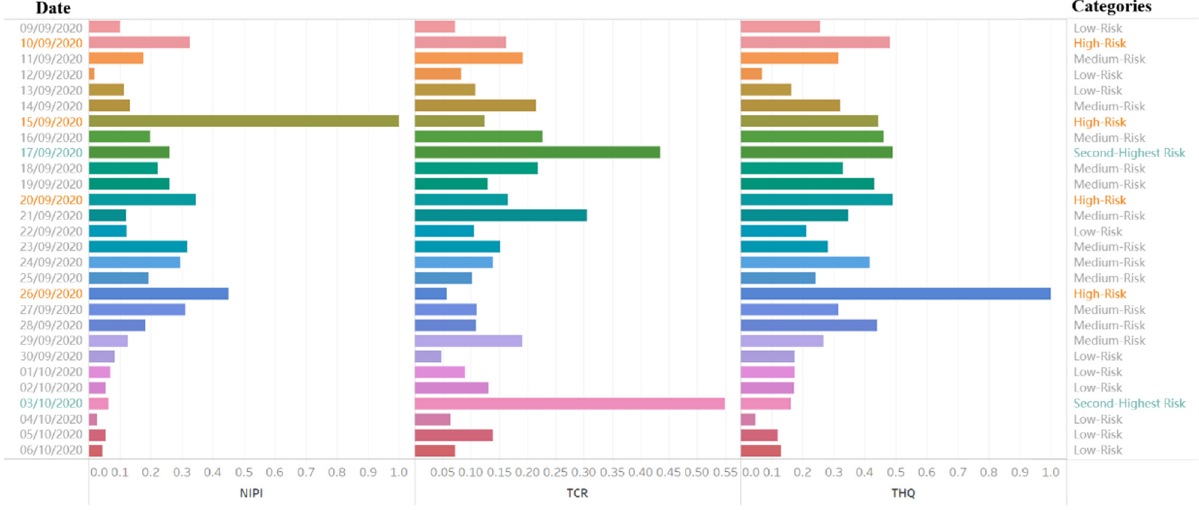
Figure 12. Risk levels and assessment indexes for certain days.